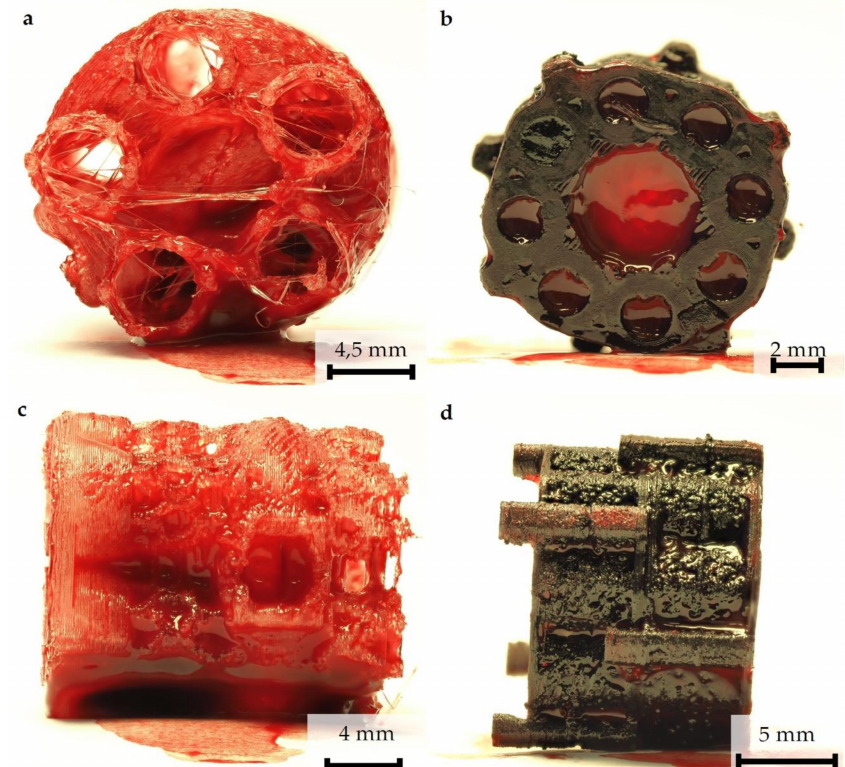
Figure 2. Blood penetration and hematoma formation in both sca ff old designs: Each sca ff old was immersed in untreated native blood for 30 s. ( a ) Axial view of design 2 after removal of the frontal cover. ( b ) Axial view of design 1. ( c ) Side view of design 2. ( d ) Side view of design 1. Two sca ff olds were combined. The connection via an outer clamp system is clearly visible. The photos were taken after 3-h incubation. A complete wetting of all Sca ff old surfaces can be seen. Hematoma formation in both sca ff olds is visible in the large vertical ( a , b ) and horizontal ( c , d )